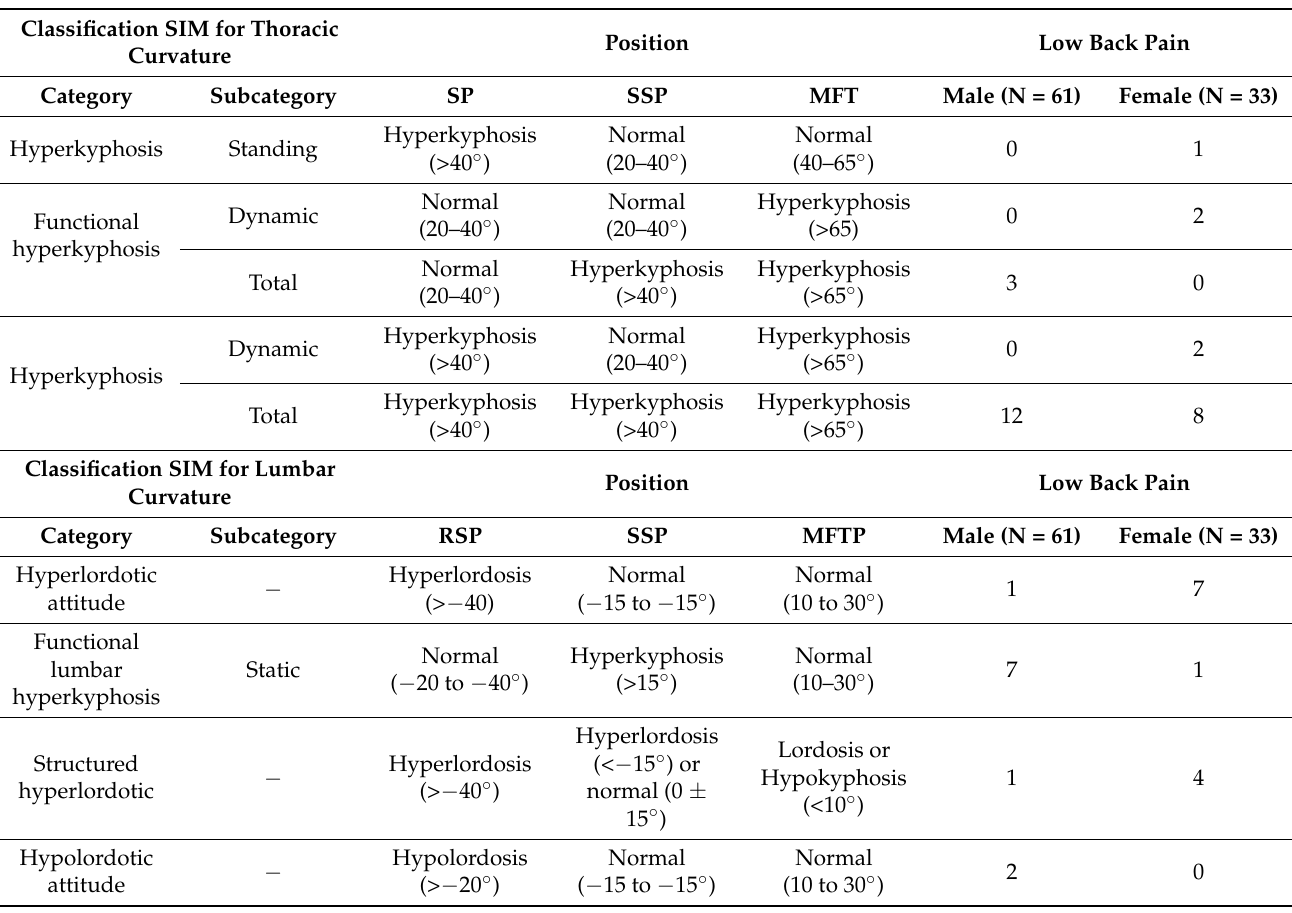
Table 6. Classification of SIM (sagittal integral morphotype) misalignments of the thoracic and lumbar curvatures of amateur competitive athletes with a history of LBP (N =